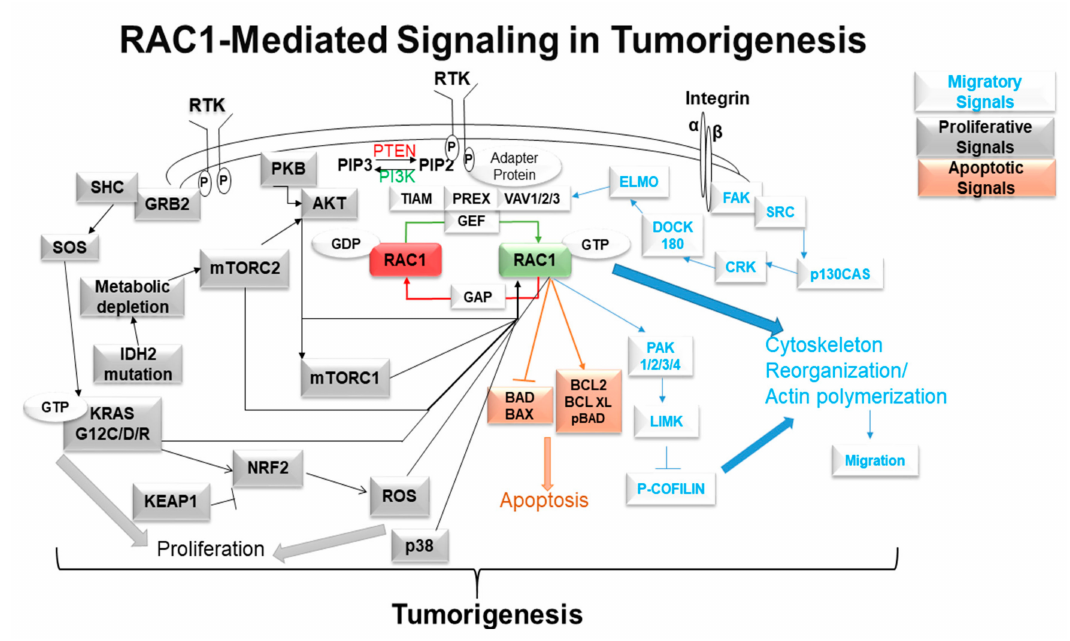
Figure 2. RAC1-mediated signaling in tumorigenesis: the cartoon presents the cellular signaling involving the activation of RAC1 in solid tumors. Following the activation of RAC1, a number of oncogenic cellular pathways are activated in tumor cells. The specific modes of involvement of the pathways and phenotypes are presented in the context of di ff erent mechanisms of activation(s) of RAC1 in di ff erent organ-type